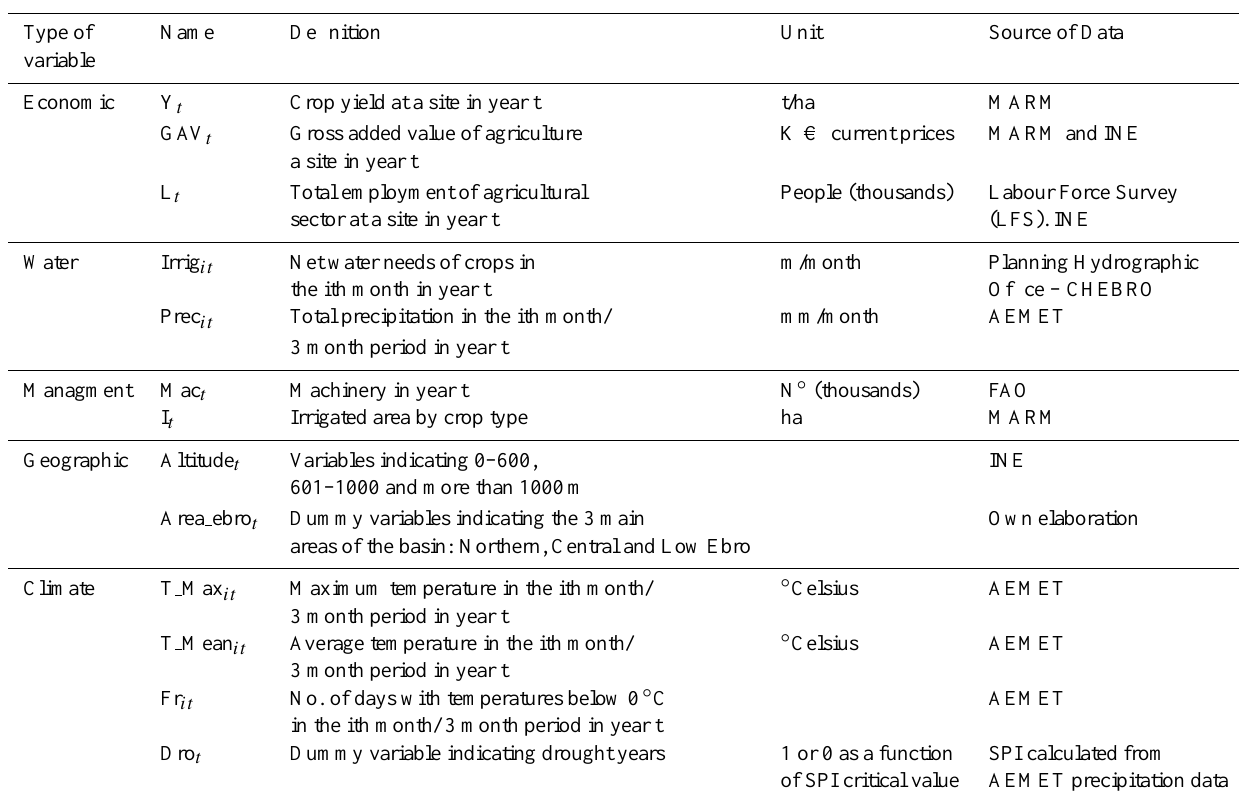
Table 2. Description of